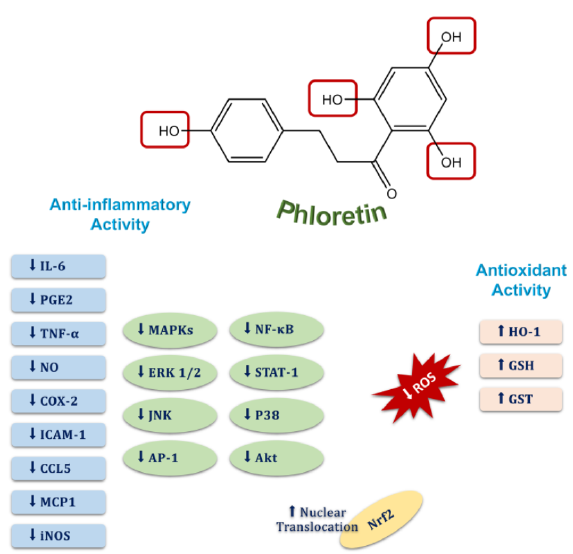
Figure 7. Molecular targets of the anti-inflammatory and antioxidant activities of